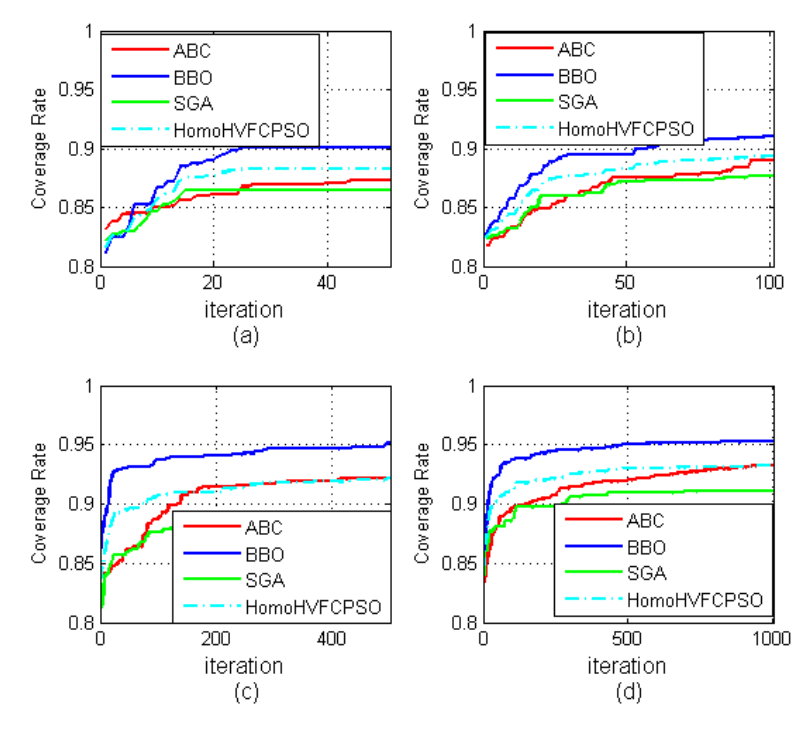
Figure 3. Average development of the populations through the different iterations for ABC, BBO, Homo-H-VFCPSO and SGA algorithms in 100 Monte Carlo